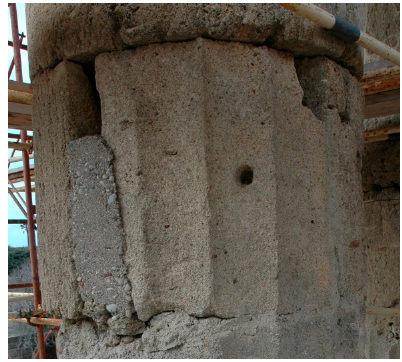
Figure 27. Concrete and cement products were used to fill the drums.